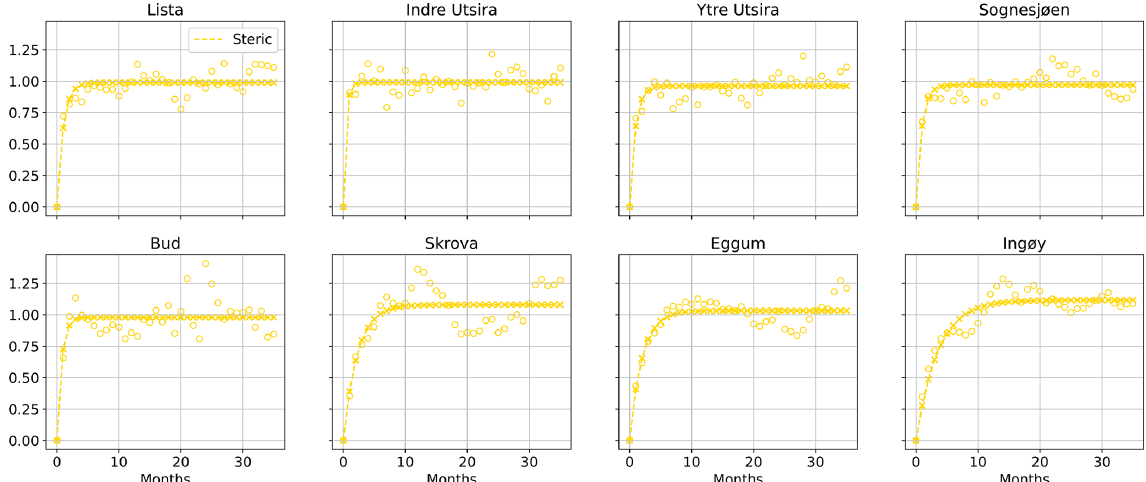
Figure B3. For each hydrographic station along the Norwegian coast, semi-variogram of the detrended and deseasoned steric component of the sea-level variability (empty circles) and corresponding fit (crosses connected by a dashed line). At each hydrographic station location, we scaled each semi-variogram by the variance of the corresponding detrended and deseasoned steric component of the sea level for all the plots to have the same limits on the y